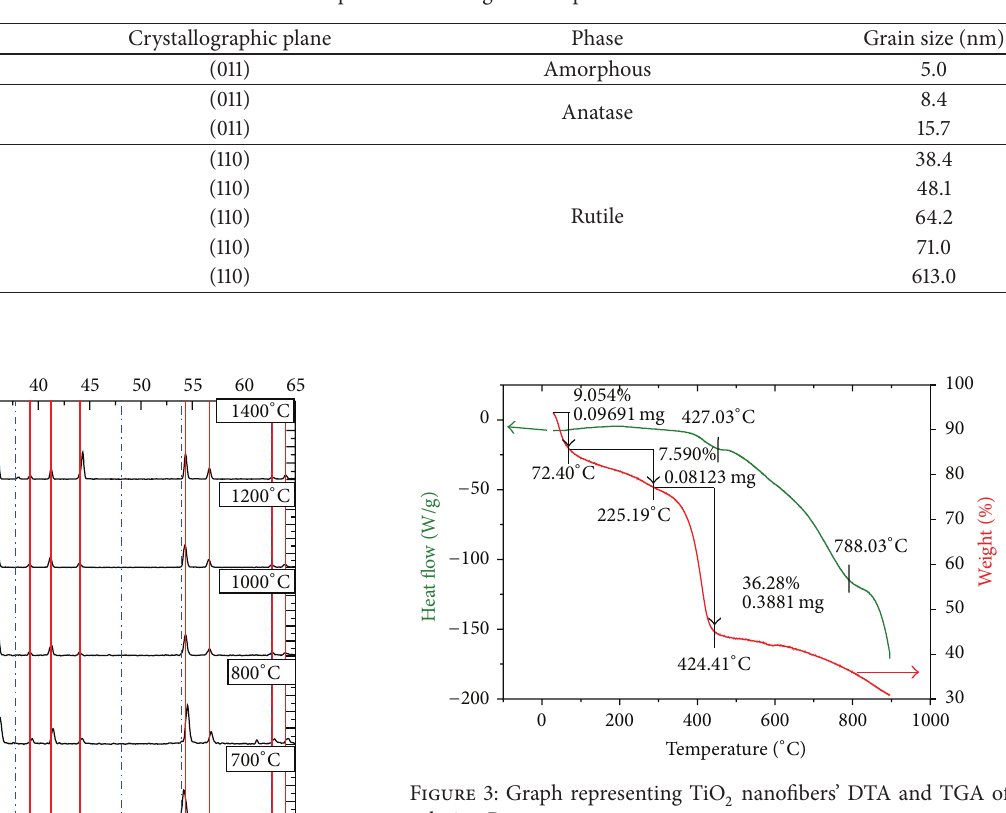
Table 3: Grain size and phase with changes of temperature.